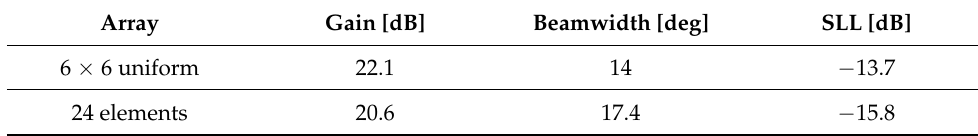
Table 2. Comparison of uniform 6 × 6 and 24 elements